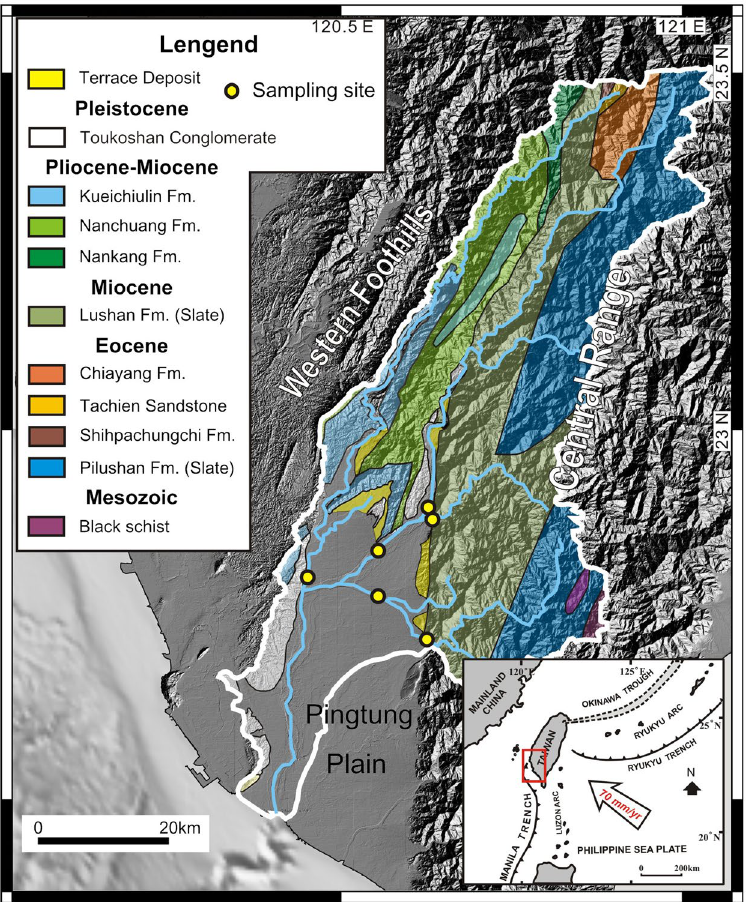
Figure 1. Gaoping River catchment. Geological and hydrological overview with sampling locations. Redrawn after geologic map of Taiwan 44 , which is openly accessible (https://data.gov.tw/dataset/11004). Topographic features were added from open access digital elevation data (https://data.gov.tw/dataset/35430) and shaded with QGIS (QGIS Development Team (2018). QGIS Geographic Information System. Open Source